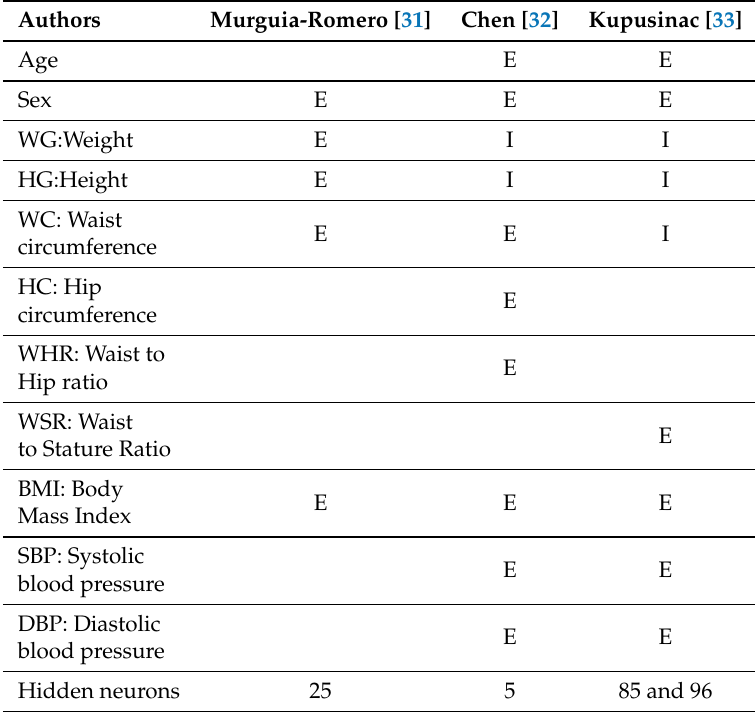
Table 2. Variables and hidden neurons of ANN used by the authors found in the review.